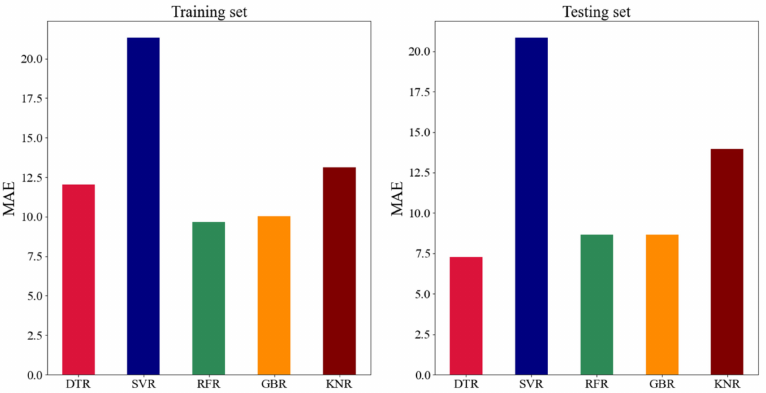
Figure 1. The mean absolute error of the different ensemble methods (decision tree regression (DTR), support vector regression (SVR), random forest regression (RFR), gradient boosting regression (GBR), and k-nearest neighbor regression (KNR)), training set, and testing